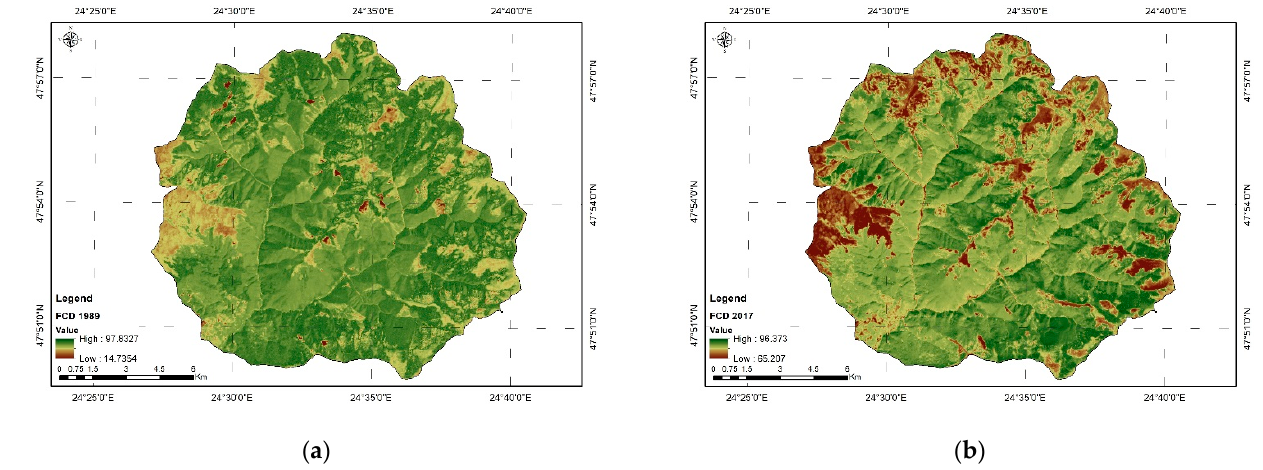
Figure 8. Forest canopy density (FCD). ( a ) FCD for year 1989; ( b ) FCD for year 2017.